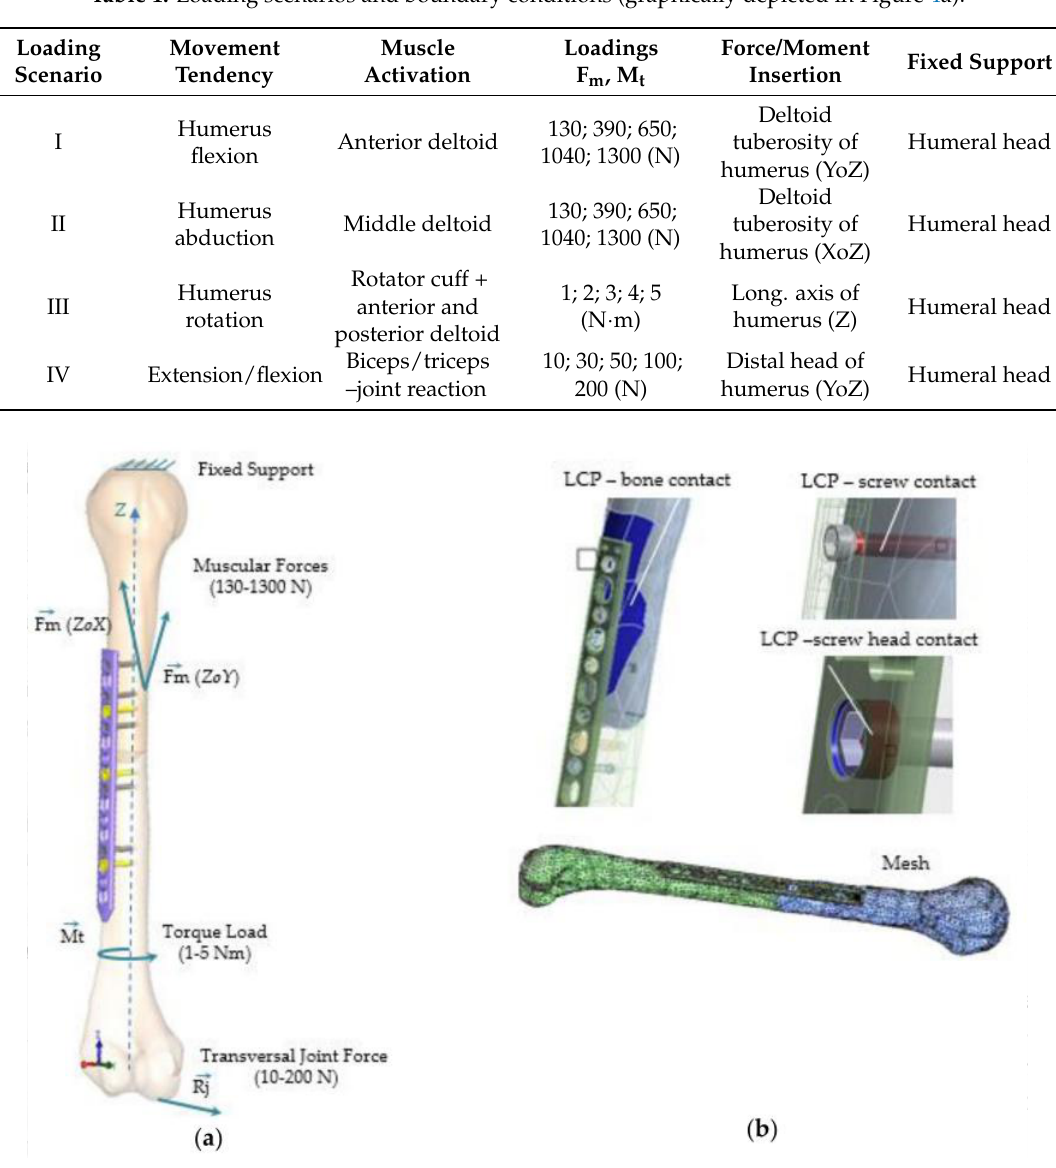
Figure 4. Structure loadings, constrains and contacts applied to the FEA model (all scenarios): ( a ) Loadings and boundary conditions; ( b ) Bonded contact definition: bone-plate, screw-plate, and